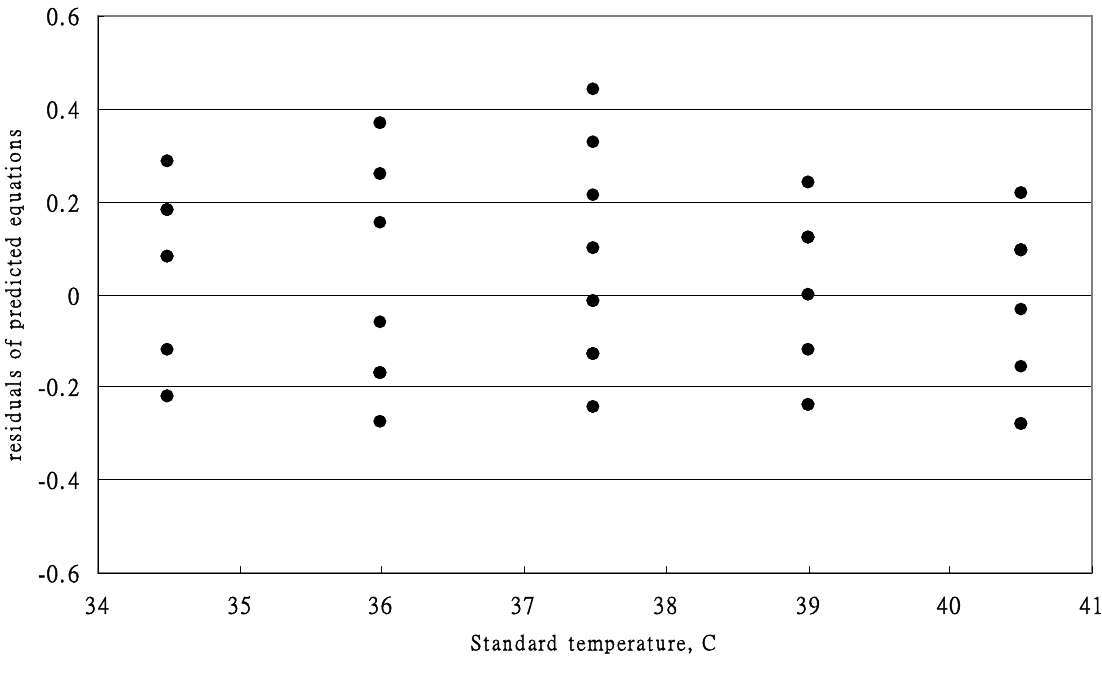
Figure 3. The predicted errors of calibration equation of OMRON MC-510